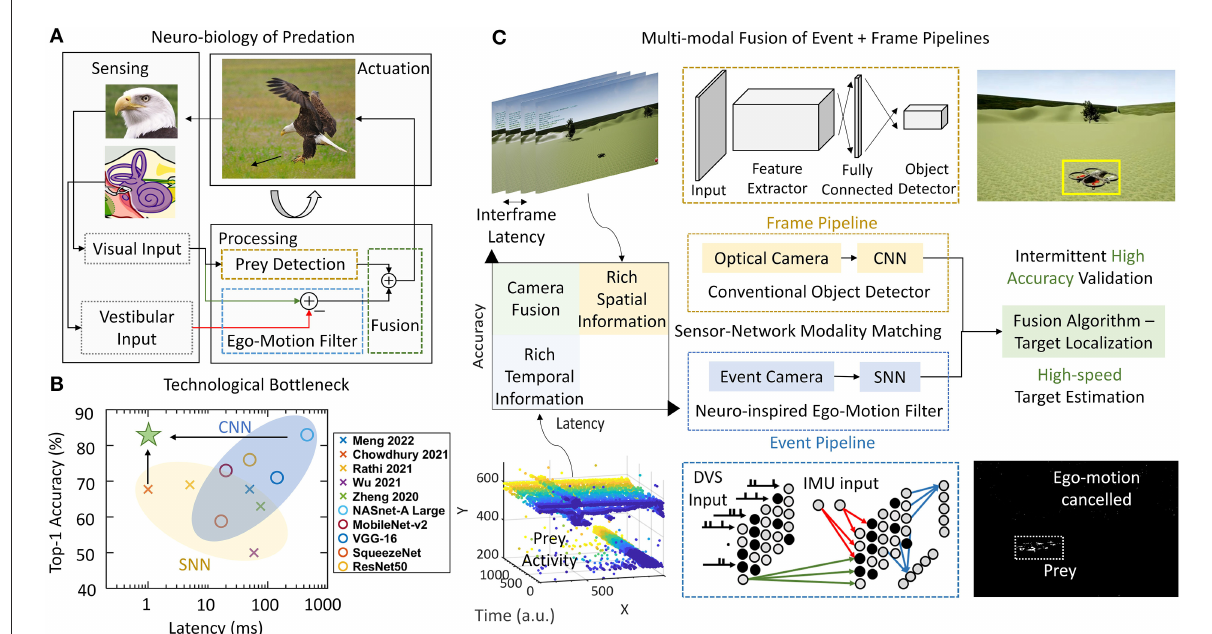
FIGURE1 (A) Predation combines vision and vestibular inputs to localize the prey in a closed-loop. This involves canceling the self-motion of the predator and identification of the prey. (B) Accuracy vs. latency trade-off between SNN and CNN. (C) Conventional optical camera + CNN (frame pipeline) for reliable object detection and a parallel event-camera + SNN (event pipeline) for high-speed ego-motion cancelation. The complementary prowess of event and frame processing is fused for target localization. 1. Eagle Eye by TwelveX is licensed under CC